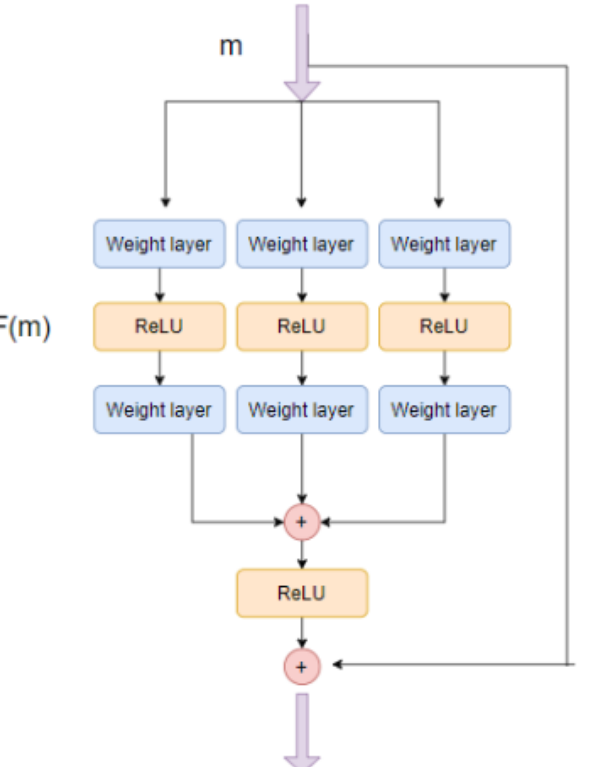
Figure 2. A ResNeXt block with skip connection This block represents Equation (2) with C =